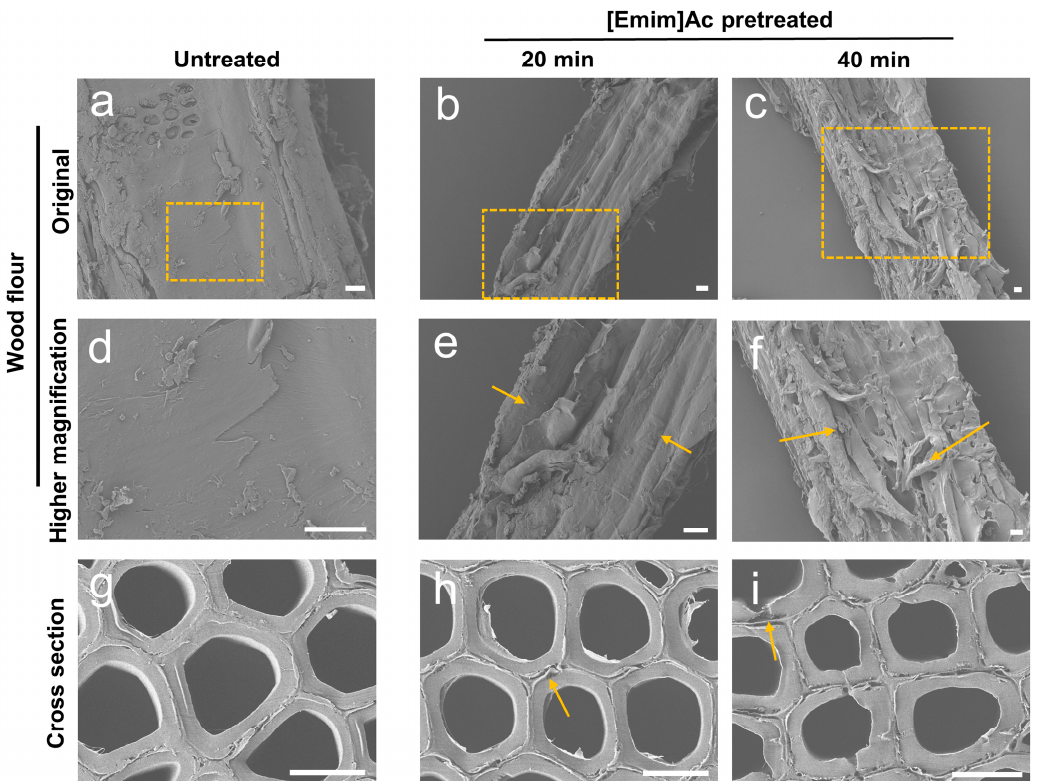
Figure 4. FE-SEM images of raw and [Emim]Ac pretreated poplar wood at 90 °C. ( a – f ) wood flour images; Images ( d – f ) are the higher magnification of the regions boxed in ( a – c ); Arrows in ( e ), ( f ) indicate cell wall deconstruction; ( g – i ) cross section images. Arrows in ( h ), ( i ) indicate lamella detachment and gaps. Scalebar = 10 μ m.